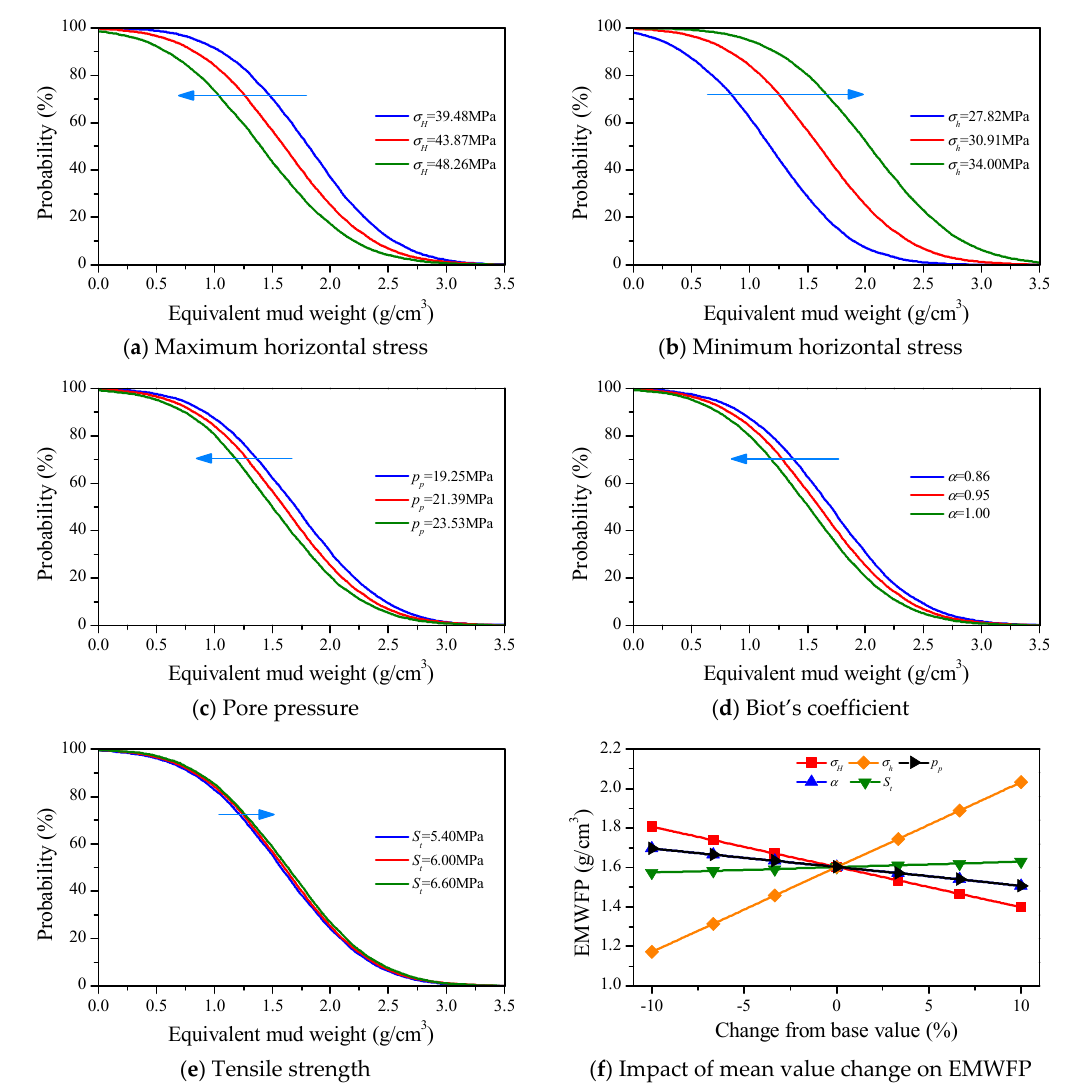
Figure 14. Influence of mean value on cumulative probability of EMWFP.